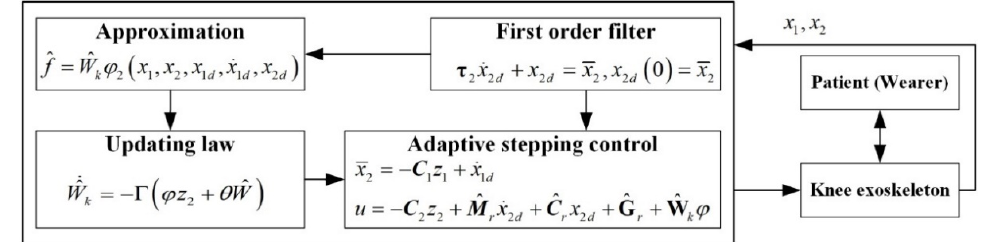
Figure 7. The control diagram.